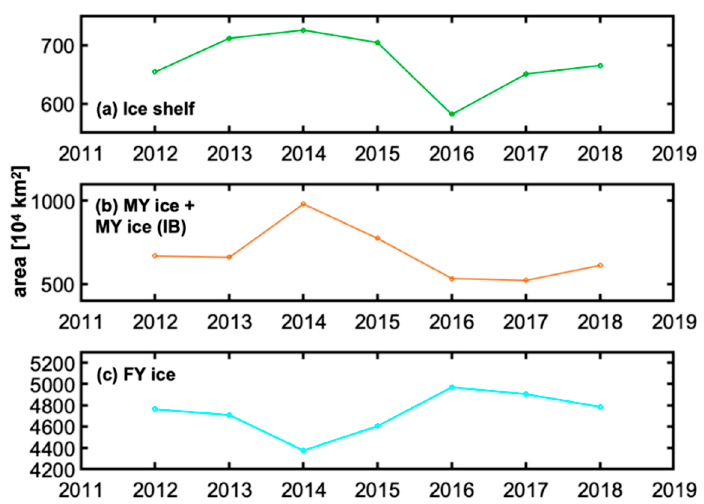
Figure 9. Time series of ( a ) the ice shelf, ( b ) MY and MY (IB) ice, and ( c ) FY ice derived from the classification algorithm in October during the period of 2012 to 2018 in the region of Lützow-Holm Bay (32–44° E, 67–71° S).